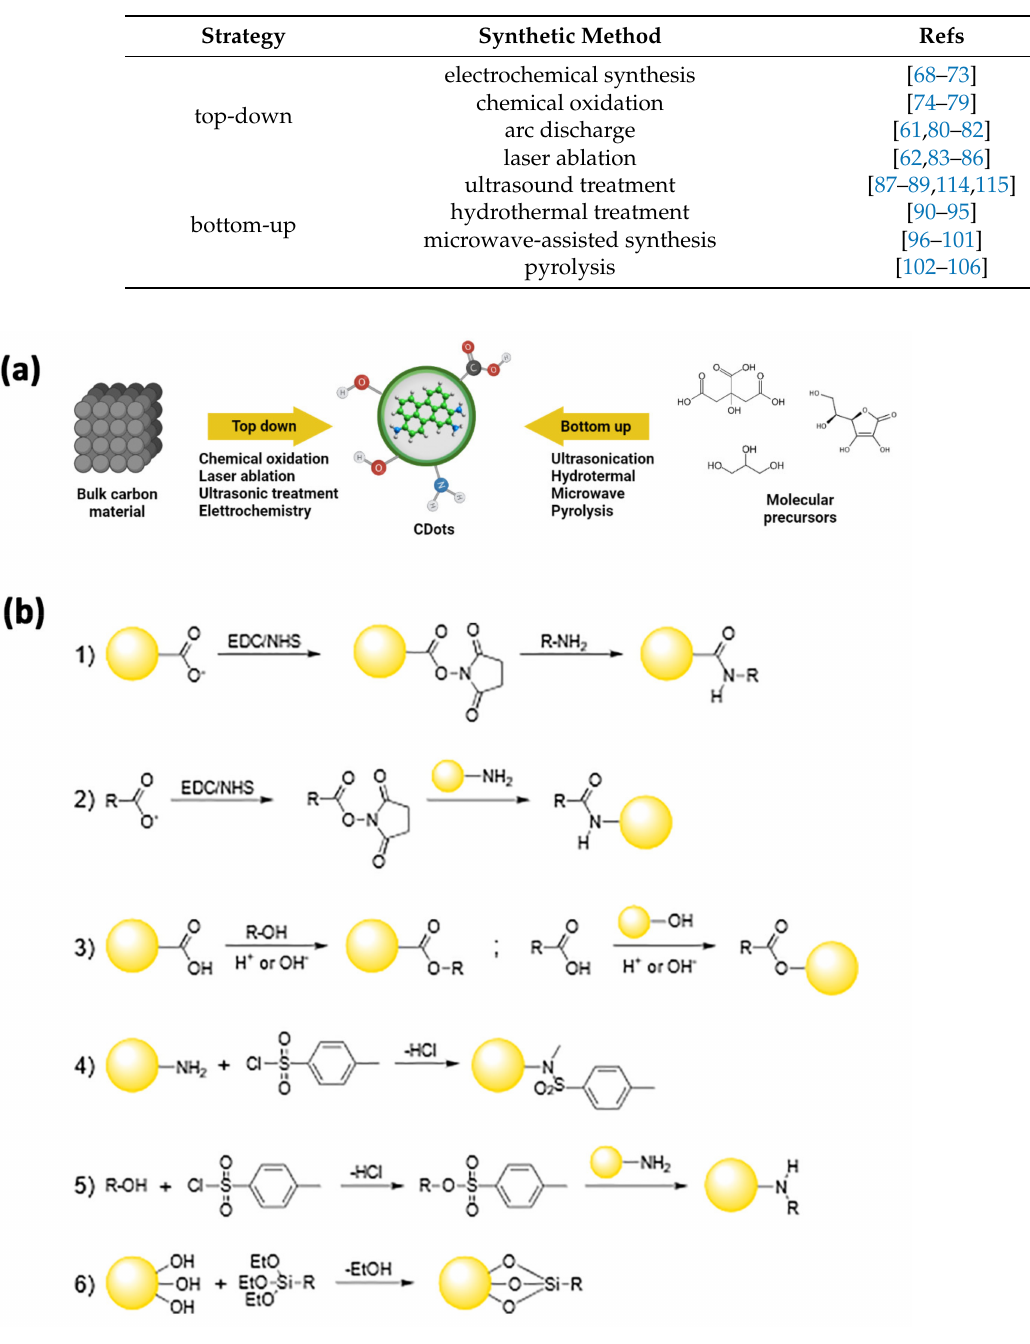
Figure 2. ( a ) General approaches for the synthesis of C-dots. In a top-down approach, C-dots are synthesized by transforming bulk carbon material into ultra-small powders via oxidation, laser ablation, ultrasounds, or electrochemical methods. In a bottom-up approach, C-dots are synthesized via physical or chemical treatments of molecular precursors that may get ionized, dissociated, evaporated, or sublimated and then condense/react to form C-dots, or via hydrothermal, sonochemical, pyrolitic treatments. ( b ) Reactions schemes for covalent strategies to C-dots functionalization: amide coupling ( 1 , 2 ), esterification ( 3 ), sulfonamide formation ( 4 ); tosylate-leaving group in nucleophilic substitution ( 5 ), sylilation ( 6